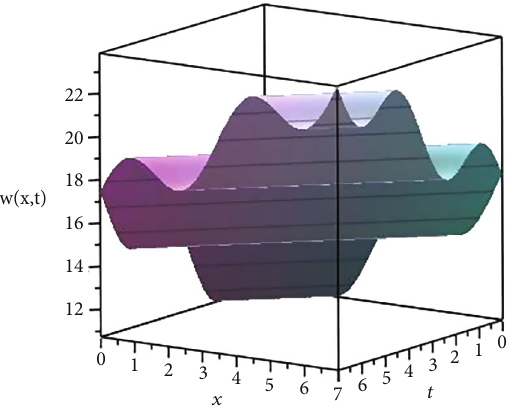
Figure 3: 3D plot of (11) for α = 1